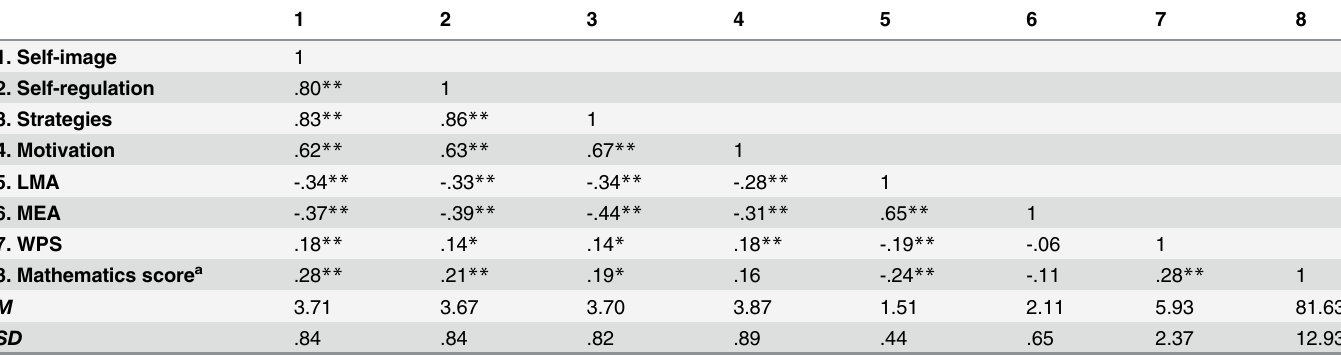
Table 1. Summary of the partial correlations, means, and standard deviations for scores on mathematical metacognition, mathematics anxiety, and word problem solving, after controlling for the Raven ’ s Standard Progressive Matrices scores and verbal comprehension subtest